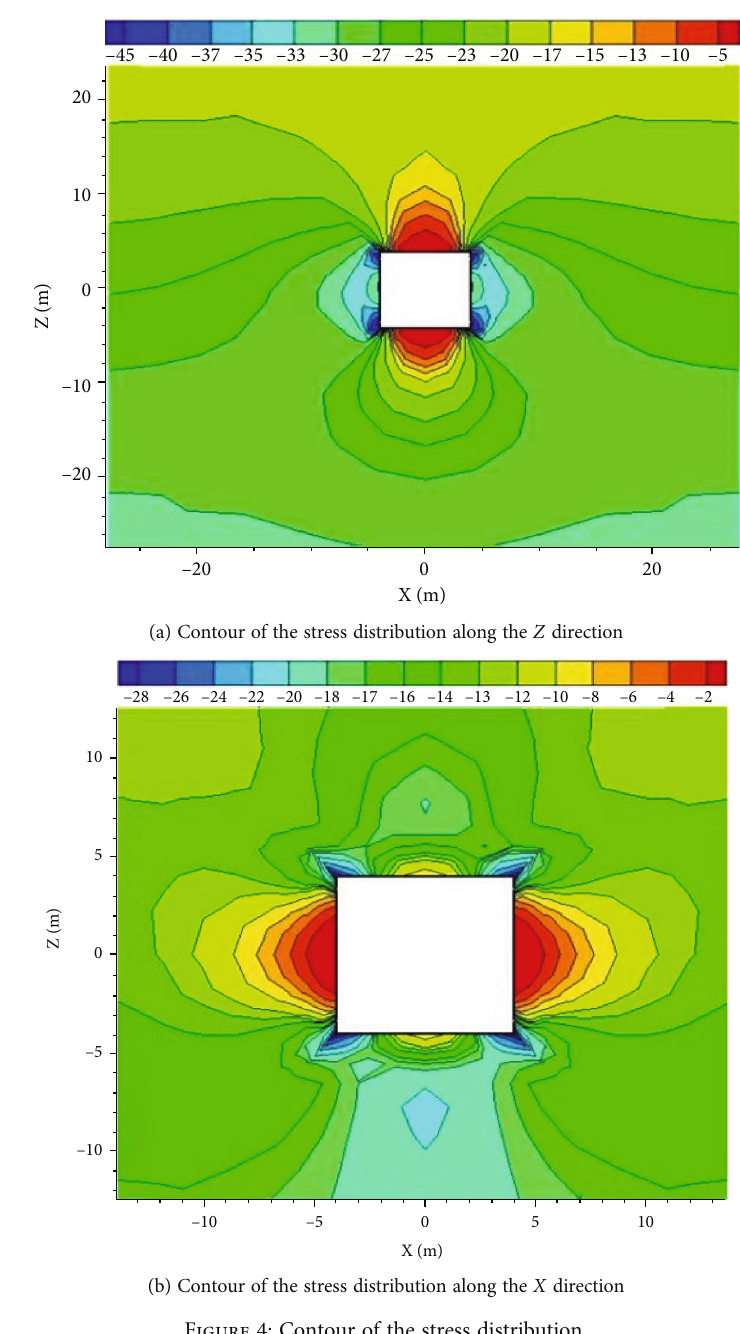
Figure 4: Contour of the stress